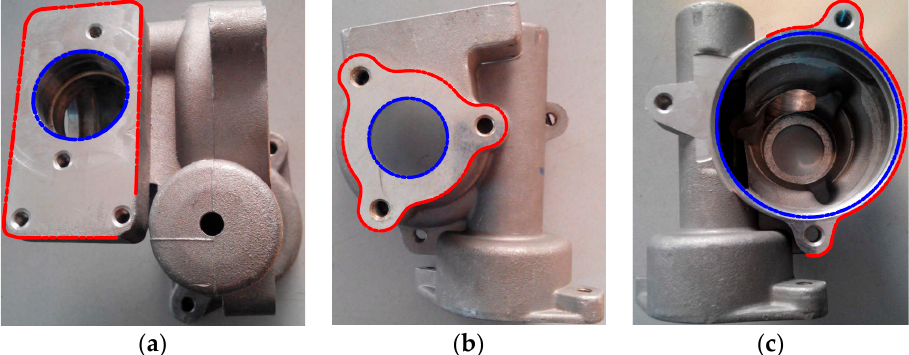
Figure 21. Experimental deburring of multifaceted edges for automobile steering booster housing: ( a ) top facet; ( b ) distal side facet; ( c ) proximal side facet.